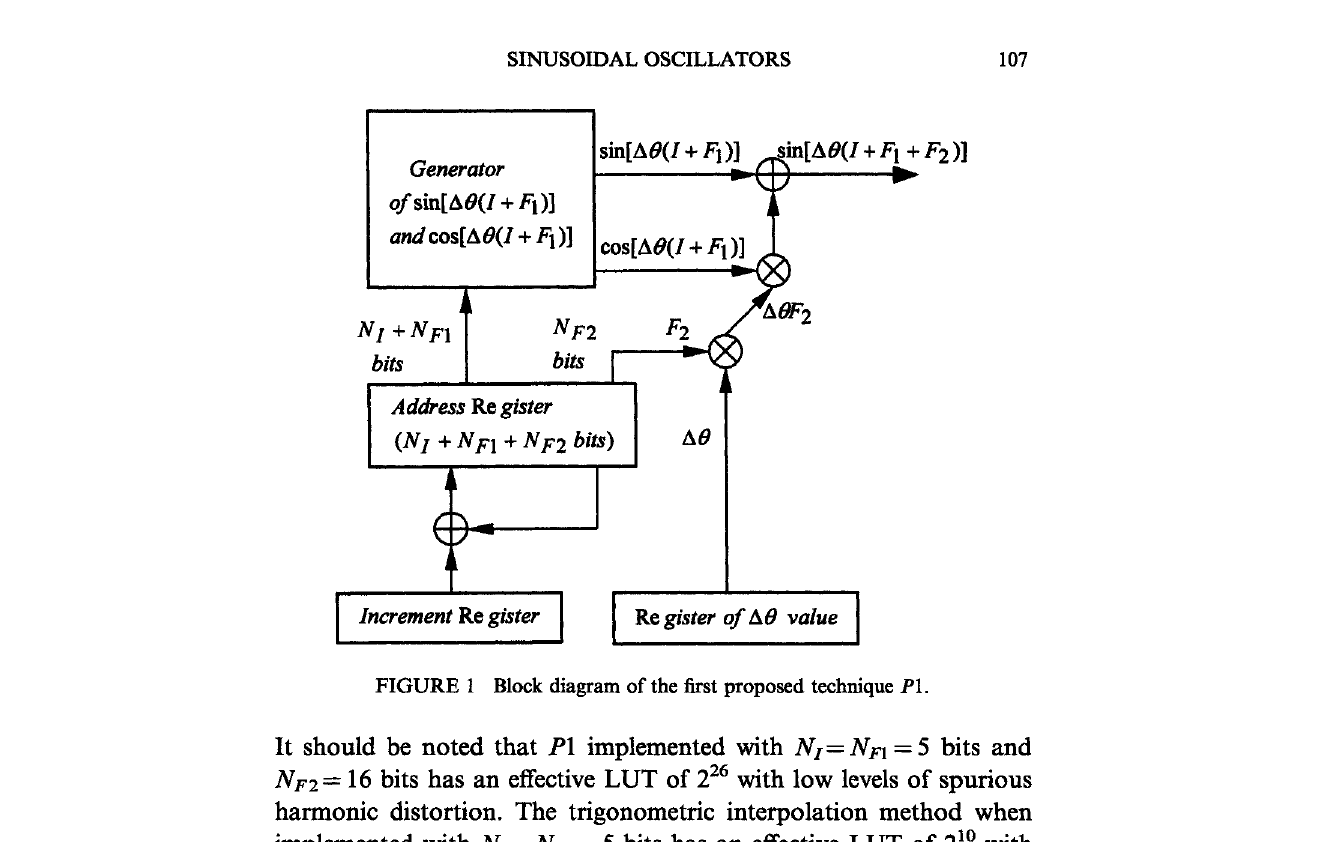
FIGURE Block diagram of the first proposed